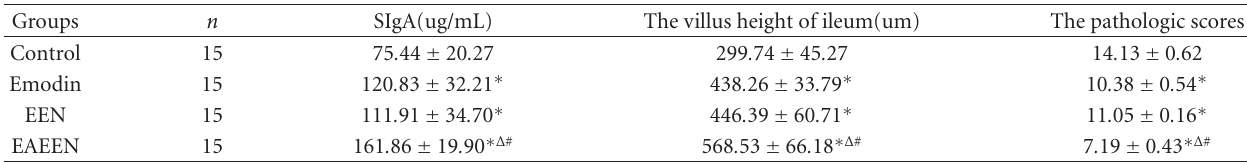
Table 3: The level of SIgA, the ileal villus height, and the pathologic scores of pancreas in 4 groups (EEN: early enteral nutrition. EAEEN: emodin-assisted early enteral nutrition. SIgA: secretory IgA).